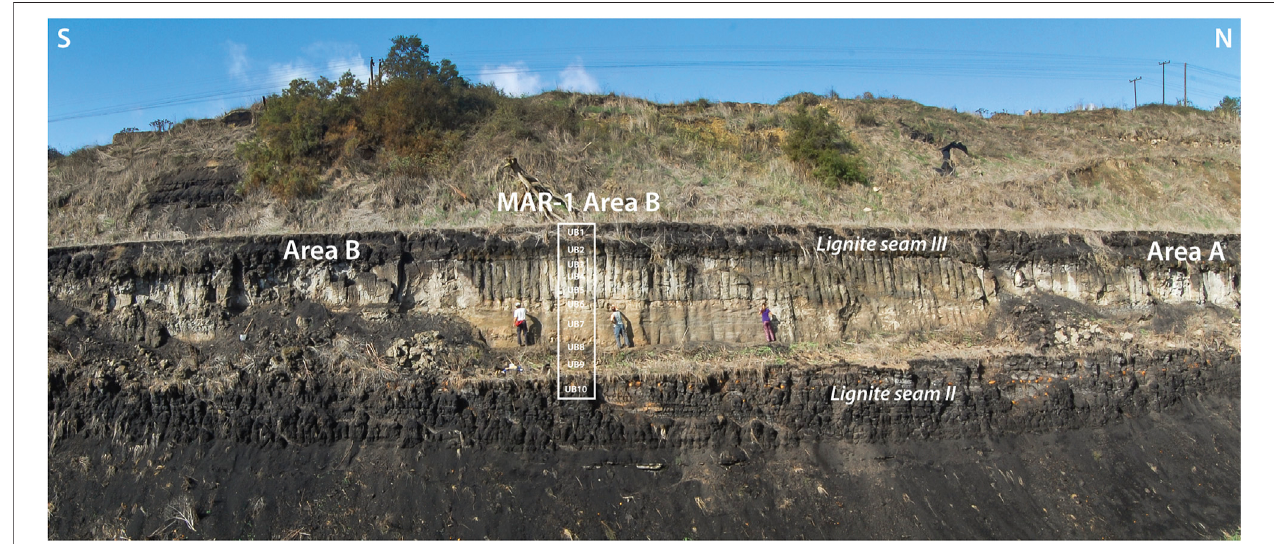
FIGURE 2 | Panoramic view of the section pro fi le at MAR-1 with excavation areas A and B between the lignite seams LGII and LGIII. The white box marks the sampling area and indicates the distribution of the stratigraphic units UB1 to UB10.